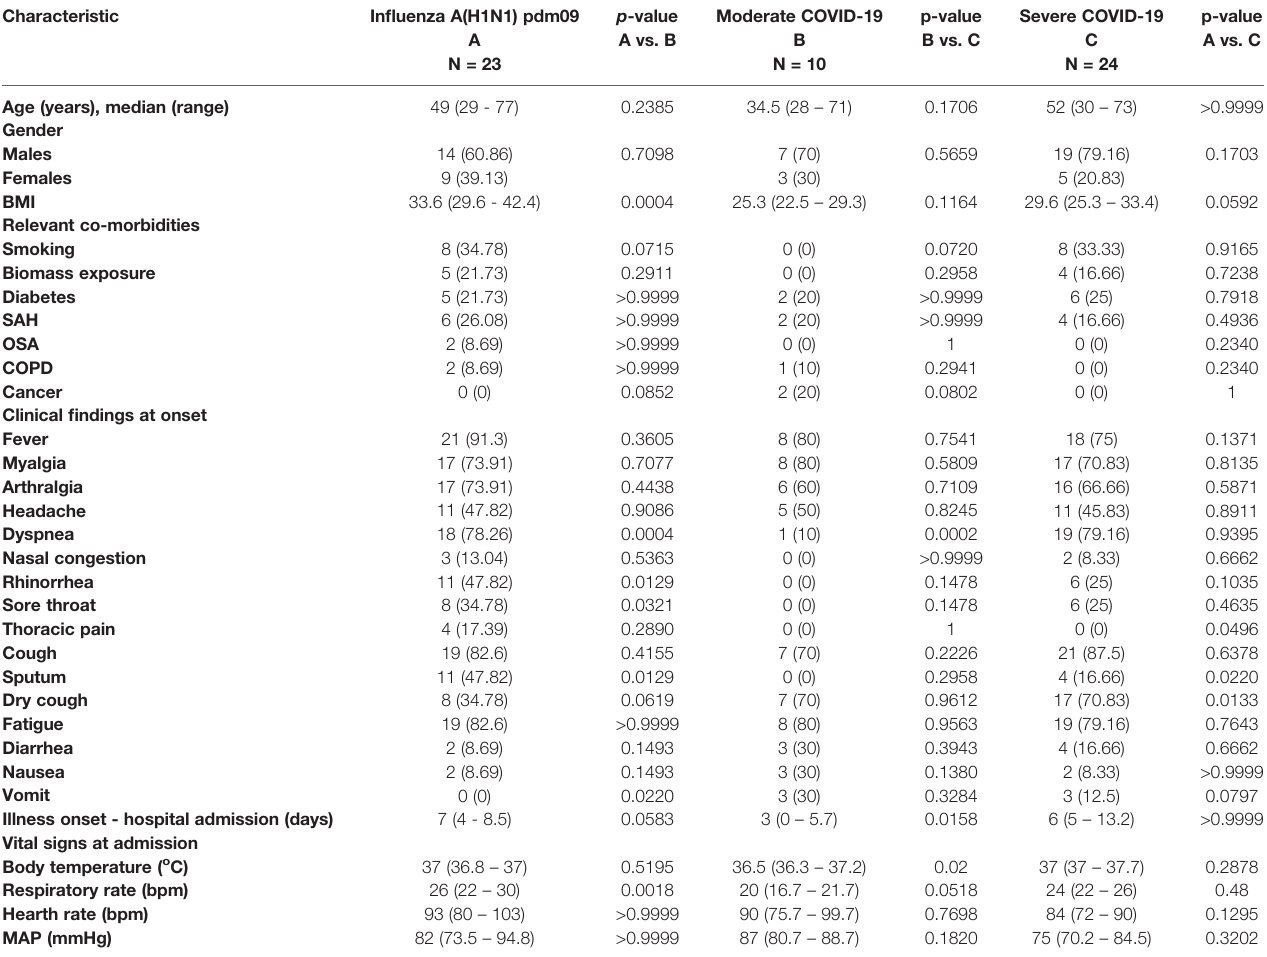
TABLE 1 | Clinical characteristics of patients with COVID-19 and pandemic in fl uenza.